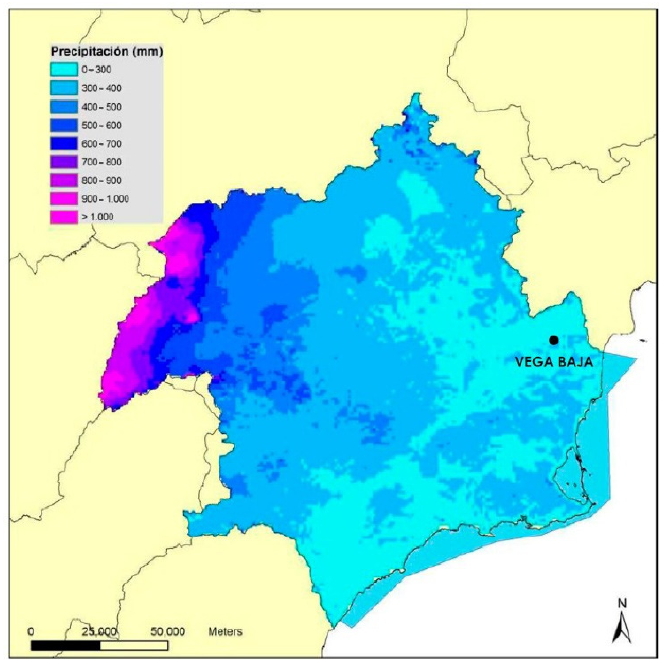
Figure 6. Annual average rainfall, period 1980–2011 [44] .